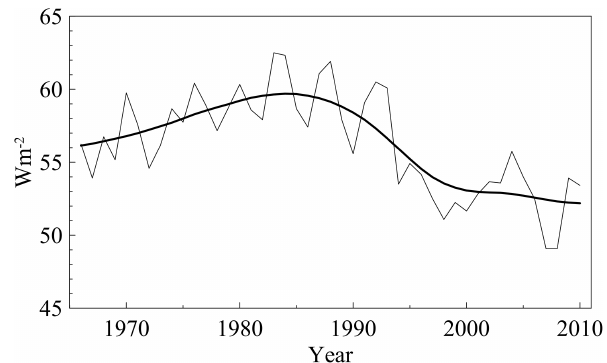
Figure 6. Long-term annual mean diffuse radiation (Wm − 2 ) record from 1966 to 2010 (thin line) plotted together with a 21- year Gaussian low-pass filter (thick line) measured at the station Toravere (Estonia) contained in